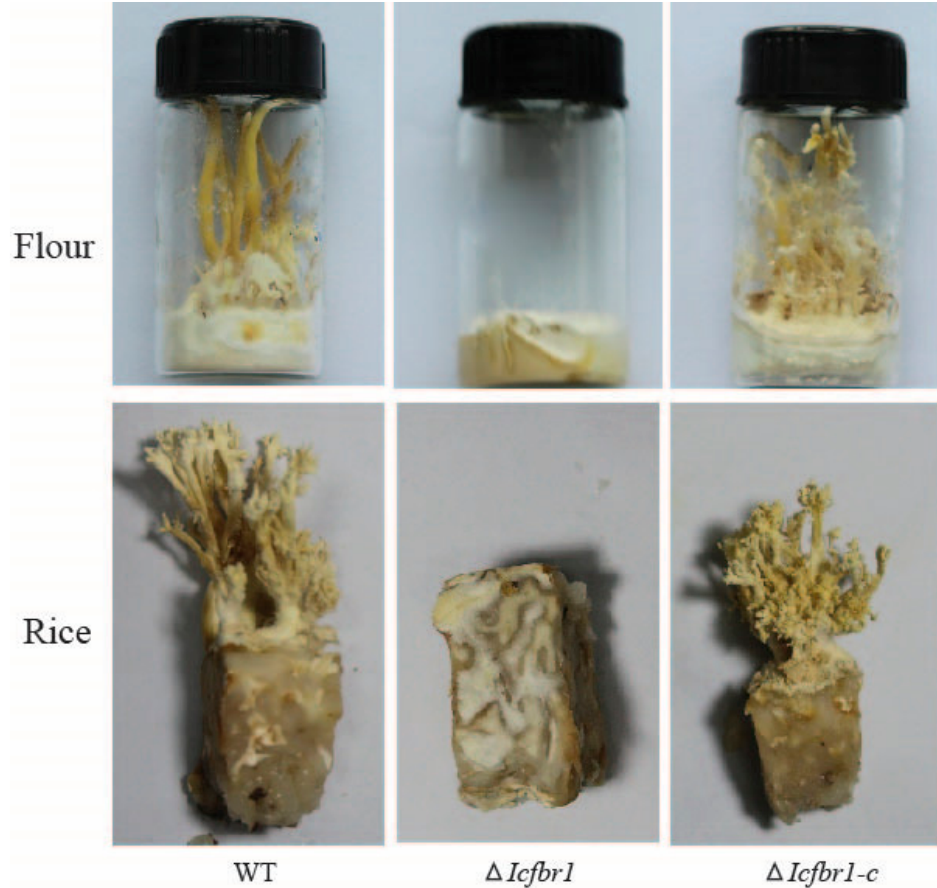
Figure 6. Production of synnemata of WT, ∆ Icfbr1 , and ∆ Icfbr1-c on flour and rice substrates.